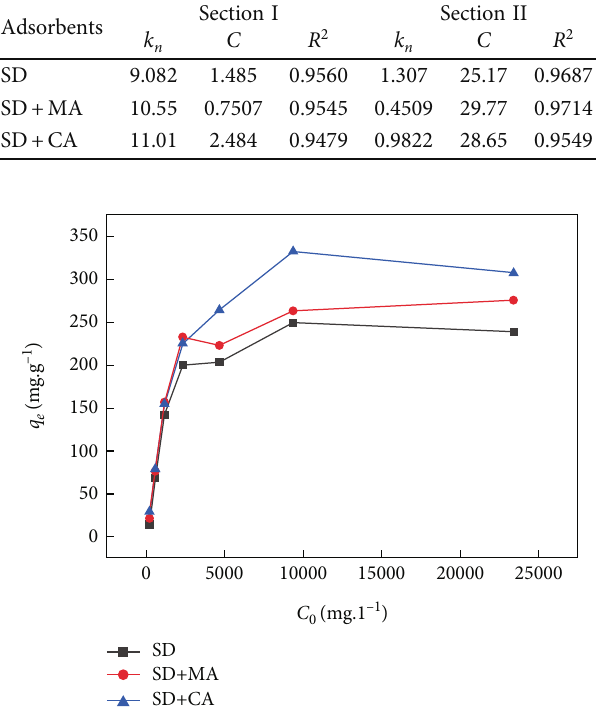
Figure 14: Adsorption isotherms of removal of boron chloride on SD, SD+ MA, and SD+